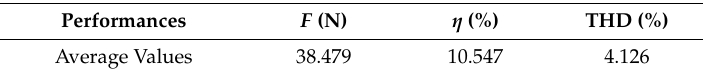
Table 4. Average values of each